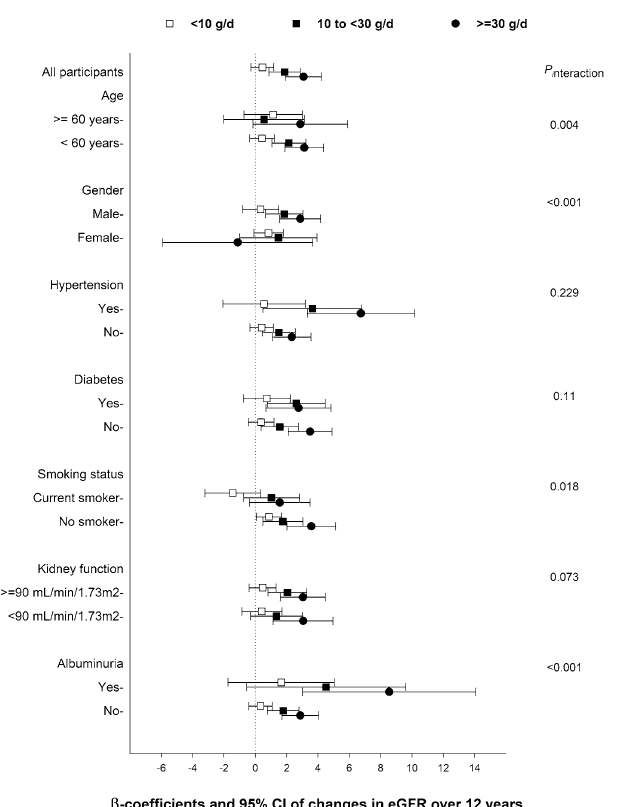
Figure 2. Overall and subgroup analyses of the association between baseline alcohol consumption and decline in kidney function over 12 years in fully adjusted linear regression model. Point and bars represent beta coefficients and 95% confidence intervals, respectively. The reference group consists of